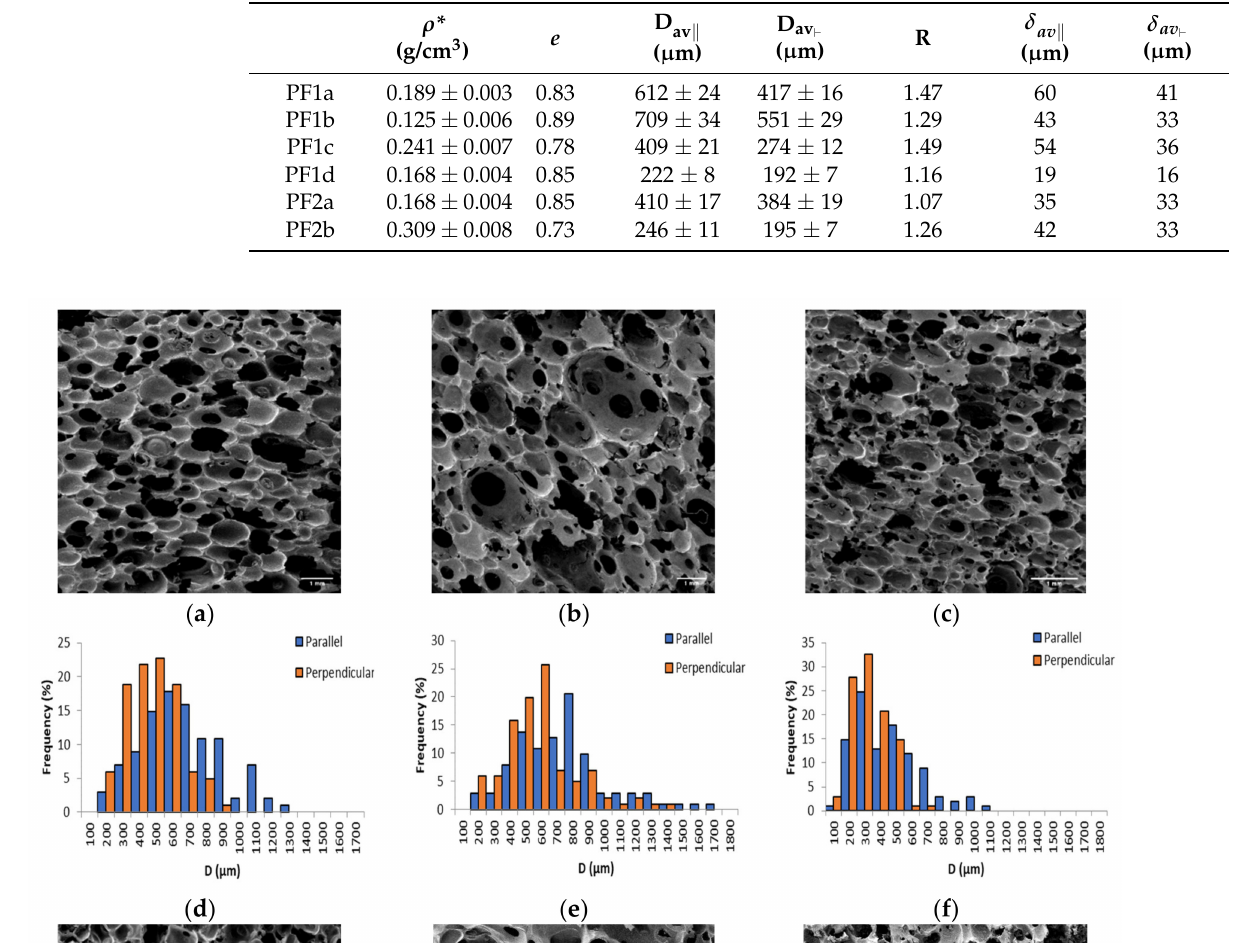
Table 2. Polymeric foam cell morphology.